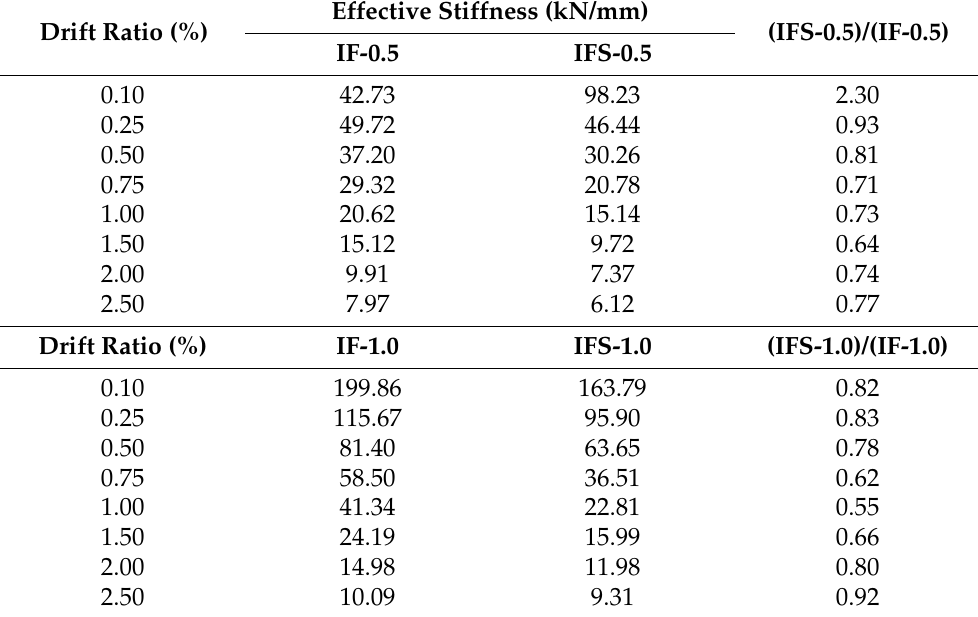
Table 4. Effective stiffness estimated from the test results.